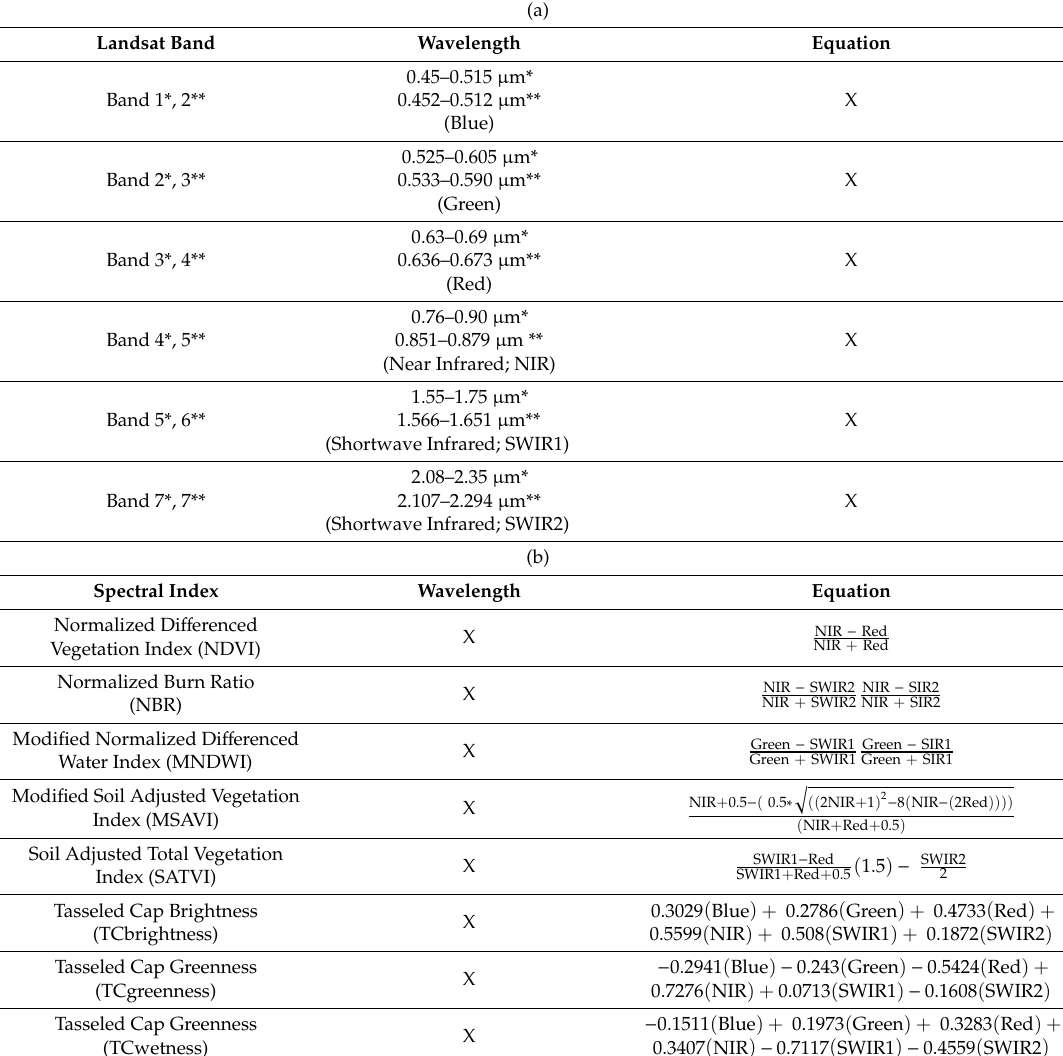
Table 1. Landsat Thematic Mapper (TM), Enhanced Thematic Mapper Plus (ETM + ), and Operational Land Imager (OLI) bands, band wavelengths (a), spectral indices, and spectral index (b) equations used during the LANDFIRE prototyping e ff ort. TM and ETM + bands and wavelengths are indicated by *, while OLI bands and wavelengths are indicated by